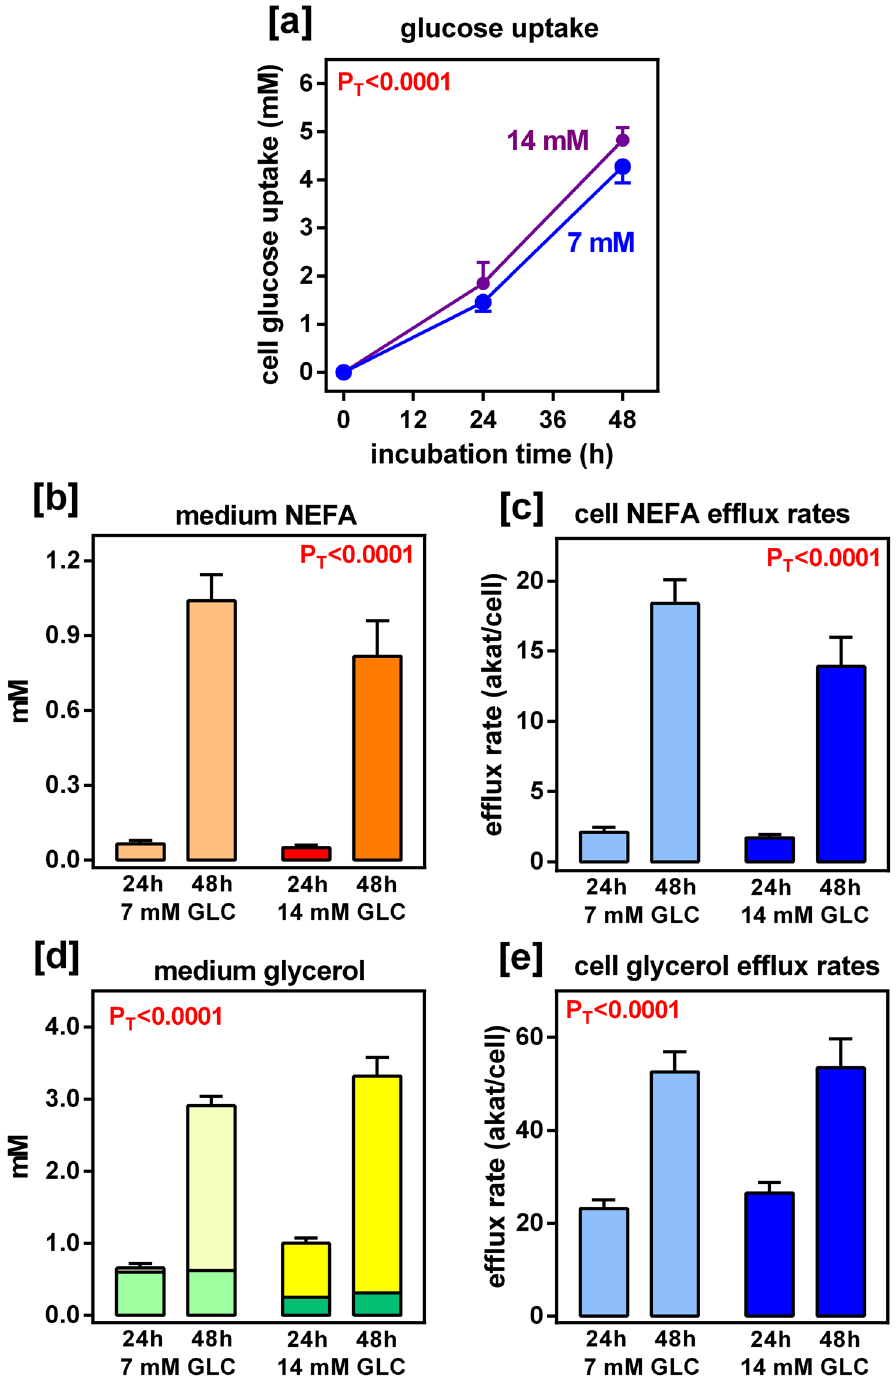
Figure 1. Effects of medium glucose concentration and incubation time on glucose uptake, and on the efflux of NEFA and glycerol, by primary cultures of rat epididymal adipocytes. The data are the mean ± sem of four different pairs (pooled) of rats; [ a ]: Glucose uptake vs. time. Blue circles: nominal initial glucose concentration 7 mM; purple circles: glucose 14 mM. In the histograms, pale shades of color correspond to 7 mM glucose in the medium, and the darker ones to 14 mM; [ b ] Effect of incubation with glucose on medium NEFA levels; [ c ] Cell NEFA efflux rates expressed in amol·s-1 per cell; [ d ]: Effect of incubation time and glucose on medium glycerol; the stacked parts of the columns show the approximate contribution of lipolytic (yellow) or phosphatase- released glycerol (green): [ e ] Effect of glucose and incubation time on cell glycerol efflux rates, also expressed as amol·s − 1 per cell. Statistical significance of the differences between groups (2-way ANOVA): PT correspond to the differences with respect to time of incubation; PG correspond to the differences with respect to initial glucose, and Pi to their interaction. Not significant values (P > 0.05) were not